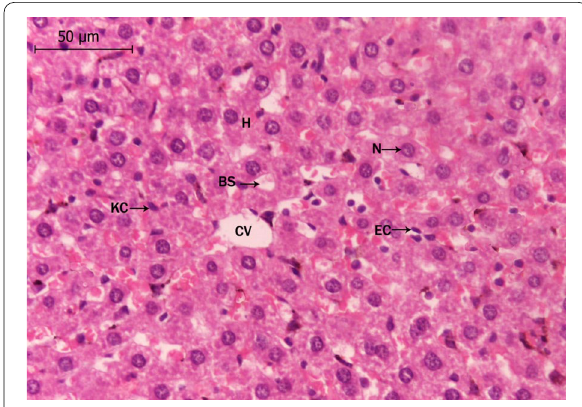
Fig. 1 A photomicrograph of a control liver section of a rat showing the typical structure of the liver cells (H), forming a network around the central vein (CV). Notice that the liver cells’ nuclei (N) are large, spherical and almost centrally located. Notice Küpffer cells (KC) in association with the blood sinusoids (BS), and endothelial cells (EC,